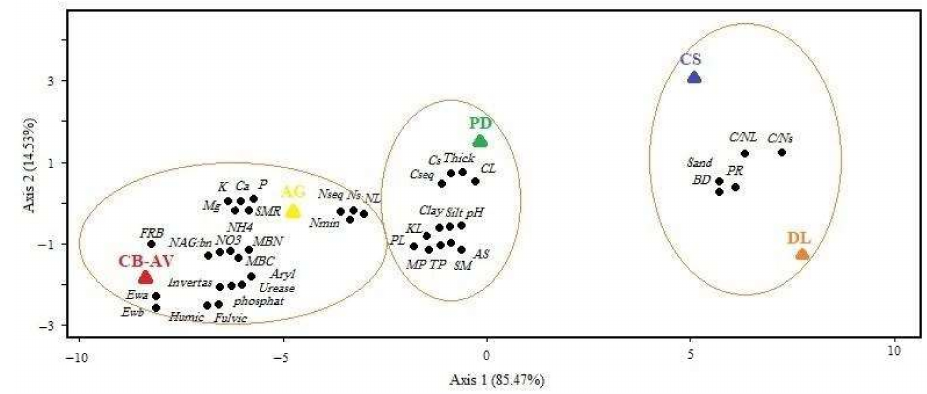
Figure 7. PCA ordination among different treatments (CB ‐ AV = natural forest stand of Carpinus betulus L. ‐ Acer velutinum Boiss.; AG = plantation of Alnus glutinosa (L.) Gaertn.; PD = plantation of Populus deltoides L.; CS = plantation of Cupressus sempervirens L. var. horizontalis (Mill.) Gord.; DL = degraded land without trees), and litter properties (Litter T = litter thickness; CL = litter C; NL = litter N (%); C/NL = litter C/N ratio; PL = litter P; KL = litter K), soil physical (BD = bulk density, TP = total porosity, MP = macroporosity, PR = penetration resistance, MC = moisture content, AS = aggregate stability, sand, silt, clay), chemical (pH, EC, C = organic C, N = nitrogen content, C/N = C/N ratio, Cseq = C storage, Nseq = N storage, P = available phosphorous, K = available potassium, Ca = available calcium, Mg = available magnesium), biochemical and biological (EW = earthworm density, Ewb = earthworm biomass, SMR = soil microbial respiration, FRB = fine root biomass, Fulvic = fulvic acid, Humic = humic acid), C and N microbial properties (SMR = soil microbial respiration, MBC = microbial biomass carbon, NH (cid:2872)(cid:2878) = ammonium, NO 3 − = nitrate, N Min = nitrogen mineralization, MBN = microbial biomass nitrogen) and enzyme activity (Urease, APH = acid phosphatase, aryl = arylsulfatase, invertase, NAG: ß ‐ N = NAG: ß ‐ N ‐ acetylglucosaminidase).